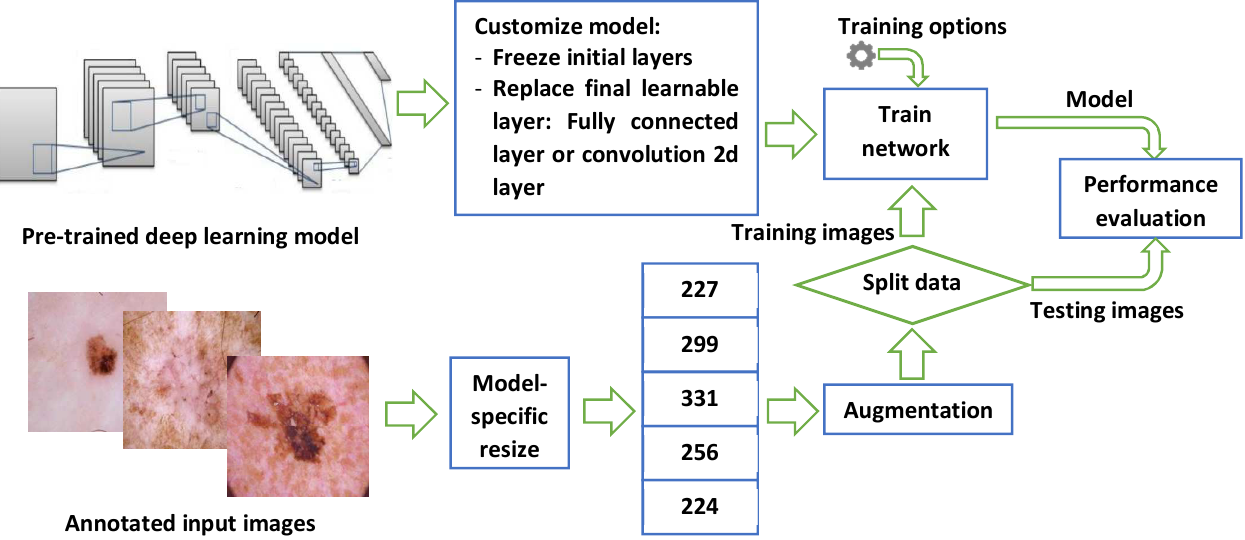
Figure 1. A graphical abstract of the general steps used in this